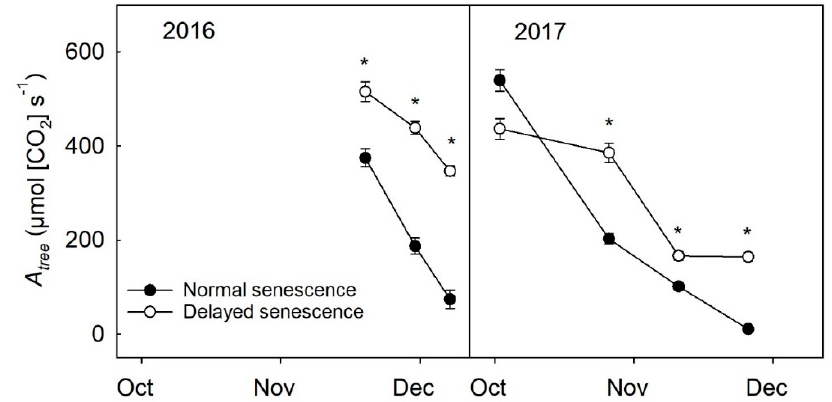
Figure 2. Estimation of whole tree assimilation ( A tree ) of normal senescence trees (filled circles) and delayed senescence trees (unfilled circles) during the fall of 2016 ( n = 16) and 2017 ( n = 12). The A tree estimate is calculated from an averaged assimilation value, leaf area, and leaf number per tree. Error bars represent ± standard error of the mean while asterisks show statistical differences ( p ≤ 0.05) between the two treatments.